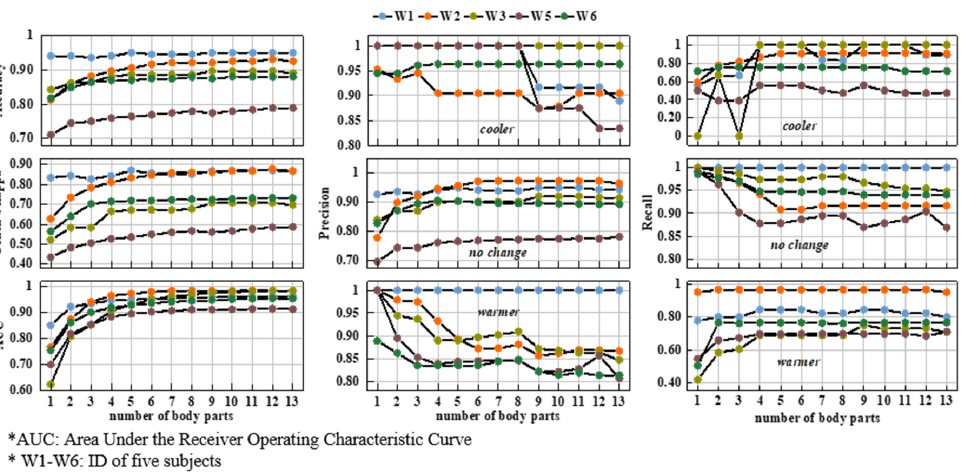
Figure 8. The average prediction powers of the combinations with different numbers of body parts.